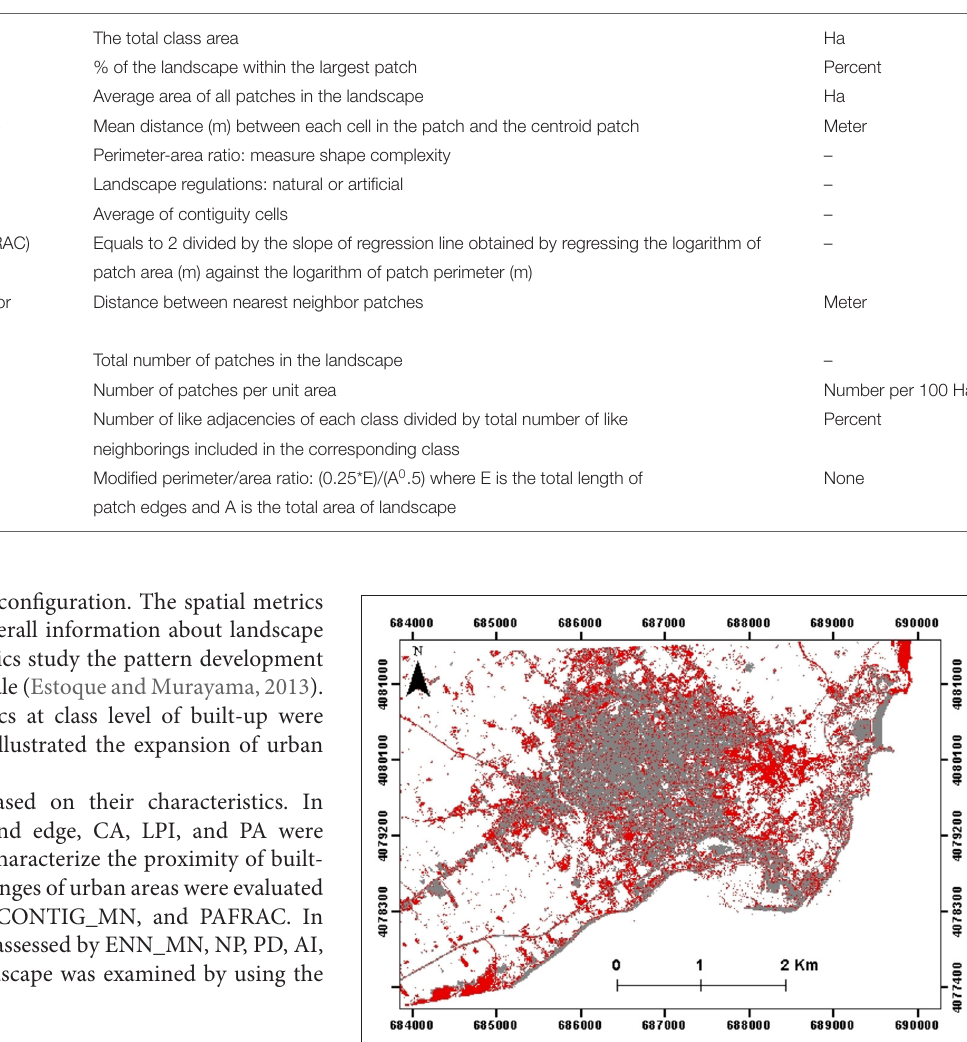
TABLE 3 | Meanings and selection reasons of landscape metrics used in this study (Mc Garigal and Marks, 1995). Metrics